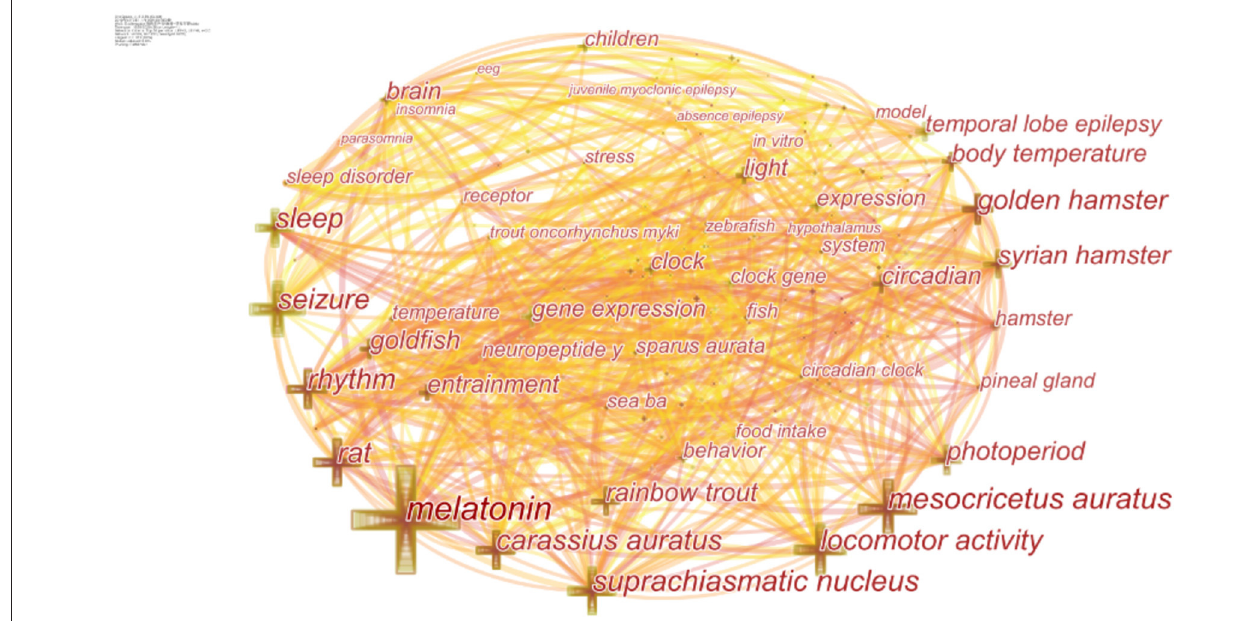
FIGURE 5 | Co-occurring keywords map.